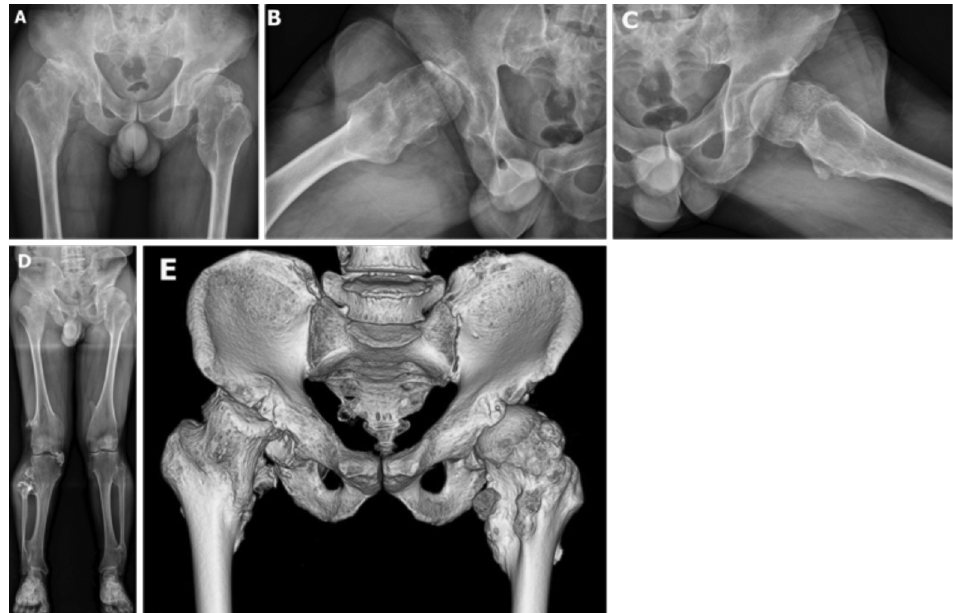
(a) Anteroposterior pelvic radiograph showing femoral head collapse and subluxation, with exostoses present on the Fig. 1: inferomedial femoral neck on both sides. (b) Right femoral head lateral radiograph. (c) Left femoral head lateral radiograph. (d) Teleroentgenogram of the lower extremity showing several exostoses in the periarticular region. (e) 3D-scan confirmed the exact position of the proximal femoral exostosis.